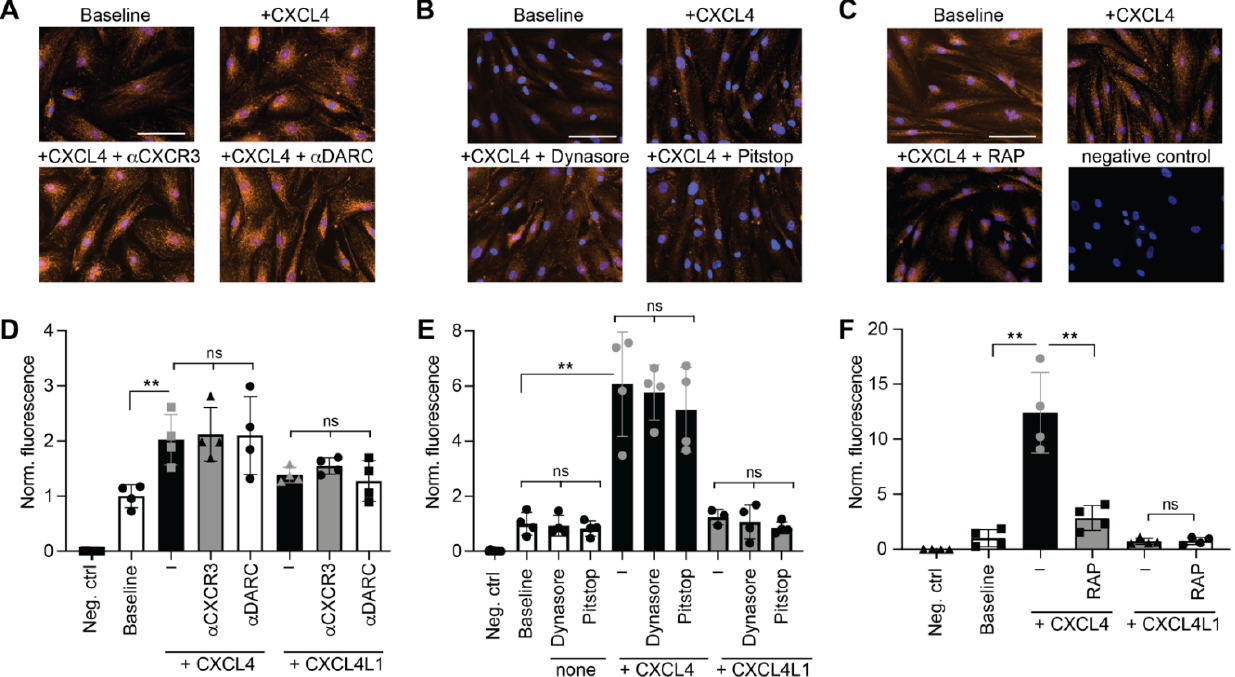
Figure 2. Molecular determinants of CXCL4 uptake. CXCL4, CXCL4L1 (at 0.5 μ g/mL) or buffer (baseline) was added to VSMCs in the presence of indicated compounds for 1 h at 37 °C, washed with heparin and stained for CXCL4 with prior permeabilization. ( A , D ) Representative images and quantitation of chemokines, co ‐ incubated with antibodies against CXCR3 or DARC and resulting intracellular CXCL4 was expressed normalized to baseline fluorescence, measured using Cytation™. ( B , E ) Representative images and quantitation of chemokines, co ‐ incubated with Dynasore (80 μ M) or PitStop2 (15 μ M) and resulting intracellular CXCL4 was expressed normalized to baseline fluorescence, measured using Cytation™. ( C , F ) Representative images and quantitation of chemokines, co ‐ incubated with RAP (200 nM) and resulting intracellular CXCL4 was expressed normalized to baseline fluorescence, measured using ImageJ. Scale bar: 100 μ m. Non ‐ significant: ns, ** p < 0.01, n = 4, one ‐ way analysis of variance (ANOVA) with Tukey’s post ‐ test ( D , E ) or with Dunnett’s post ‐ test ( F ). Representative figures of CXCL4L1 treatment are shown in Figure S3.